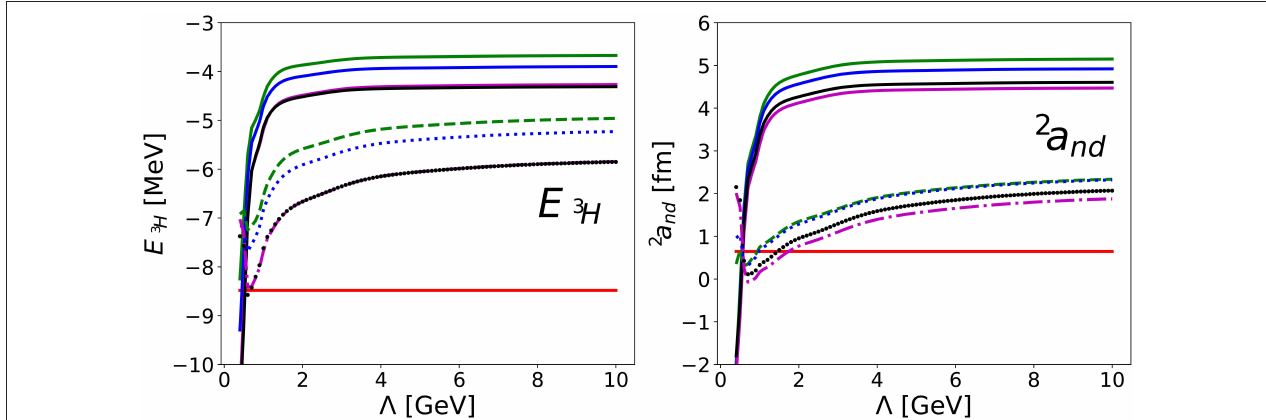
FIGURE 9 | Triton binding energy E 3 H and doublet neutron-deuteron scattering length 2 a nd as functions of the cutoff 3 . Results at LO (solid lines) and NLO (dashed and dotted lines) for various 2 N fitting procedures are compared with experiment (horizontal red lines). Reprinted figure with permission from reference [93]. Copyright (2019) by the American Physical